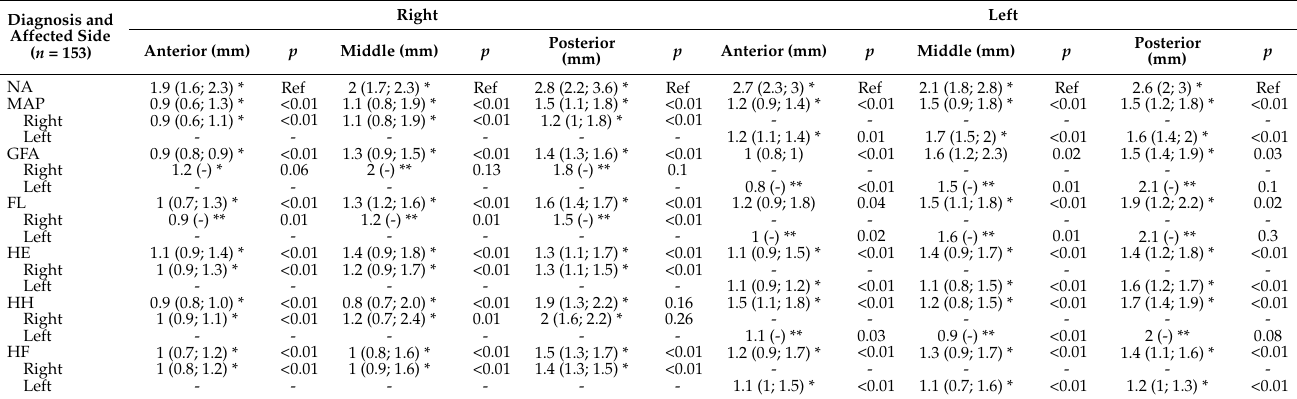
Table 7. Comparison of joint space data of without FA group vs. FA groups and